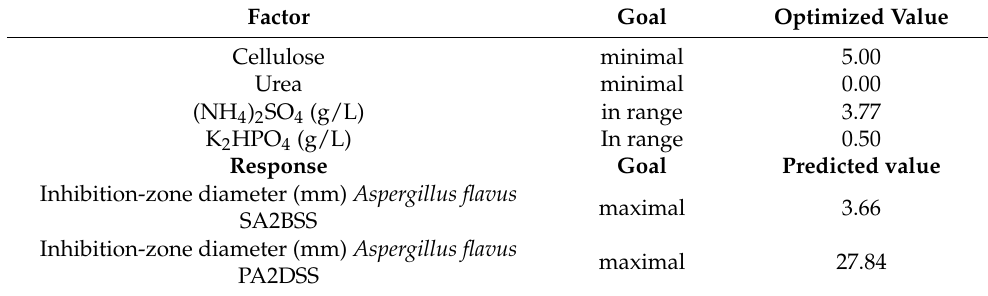
Table 13. Optimized values of varied factors and predicted values of inhibition-zone